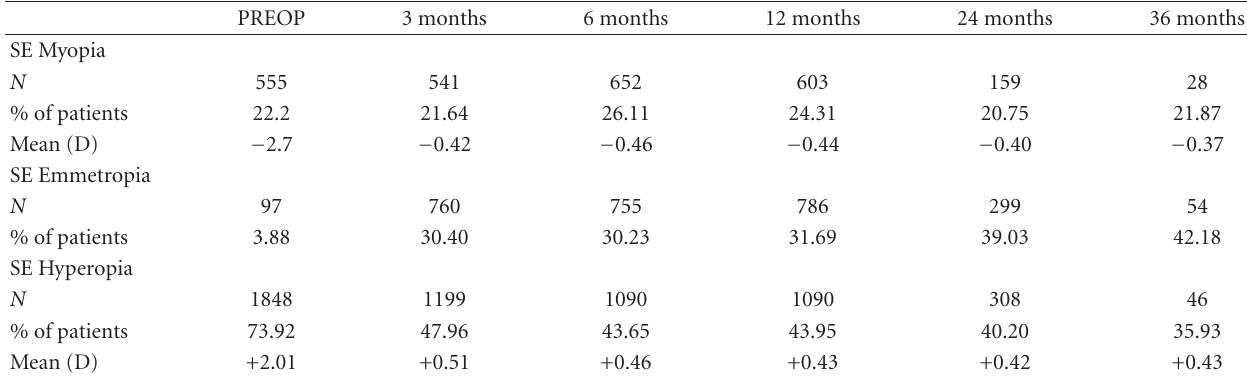
Table 4: Spherical equivalent in di ff erent periods during